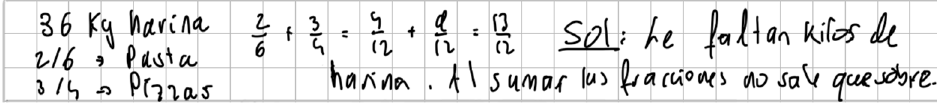
Figure 1. PT30’s written answer to problem FWP3. (Translation of P30’s solution: “The restaurant is short of kilos of flour [harina]. When adding up the fractions, there is no excess.”).